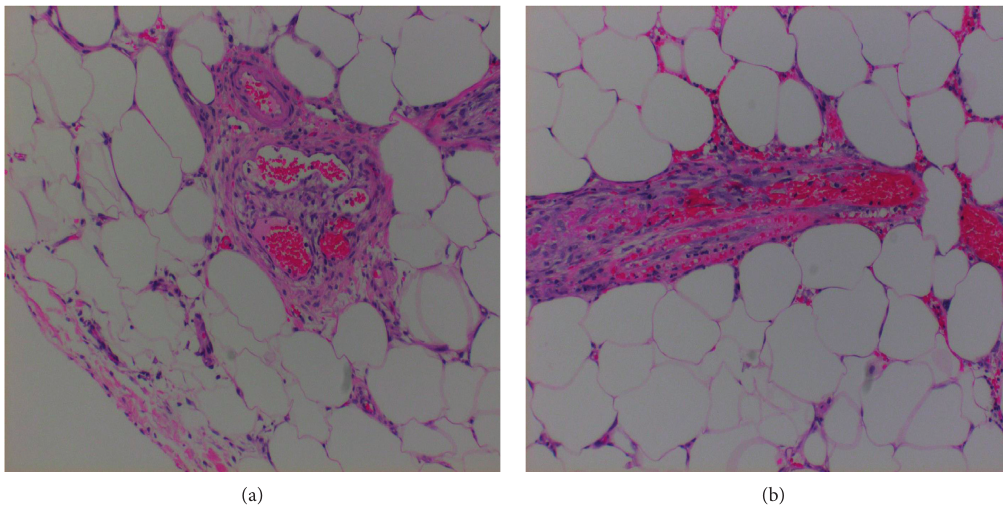
Figure 3: Histopathologic findings of (a) Soft tissue, small bowel mesentery, biopsy: mature adipose tissue with patchy chronic in- flammation and fat necrosis; (b) soft tissue, epiploic appendage, biopsy: mature adipose tissue with focal acute and chronic inflammation. Focal small vessel vasculitis and foci of